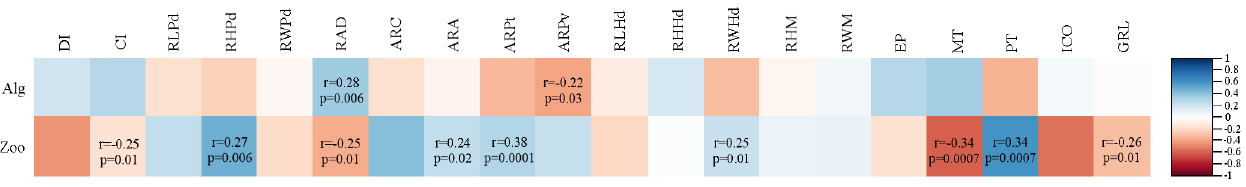
FIGURE 5 | Graph of Spearman’s correlation coefficient calculated between the morphological traits indicated by CVA and main food items consumed by Serrapinnus notomelas and Serrapinnus sp.1 in a lake in the upper Paraná River floodplain, Brazil. Values of r and p indicate the correlation and statistical significance, respectively. Positive correlations are represented by blue color and negative correlations by red color. ALG – algae; ZOO – zooplankton; DI – Depression index; CI – Compression index; RLPd – Relative lenght of caudal peduncule;